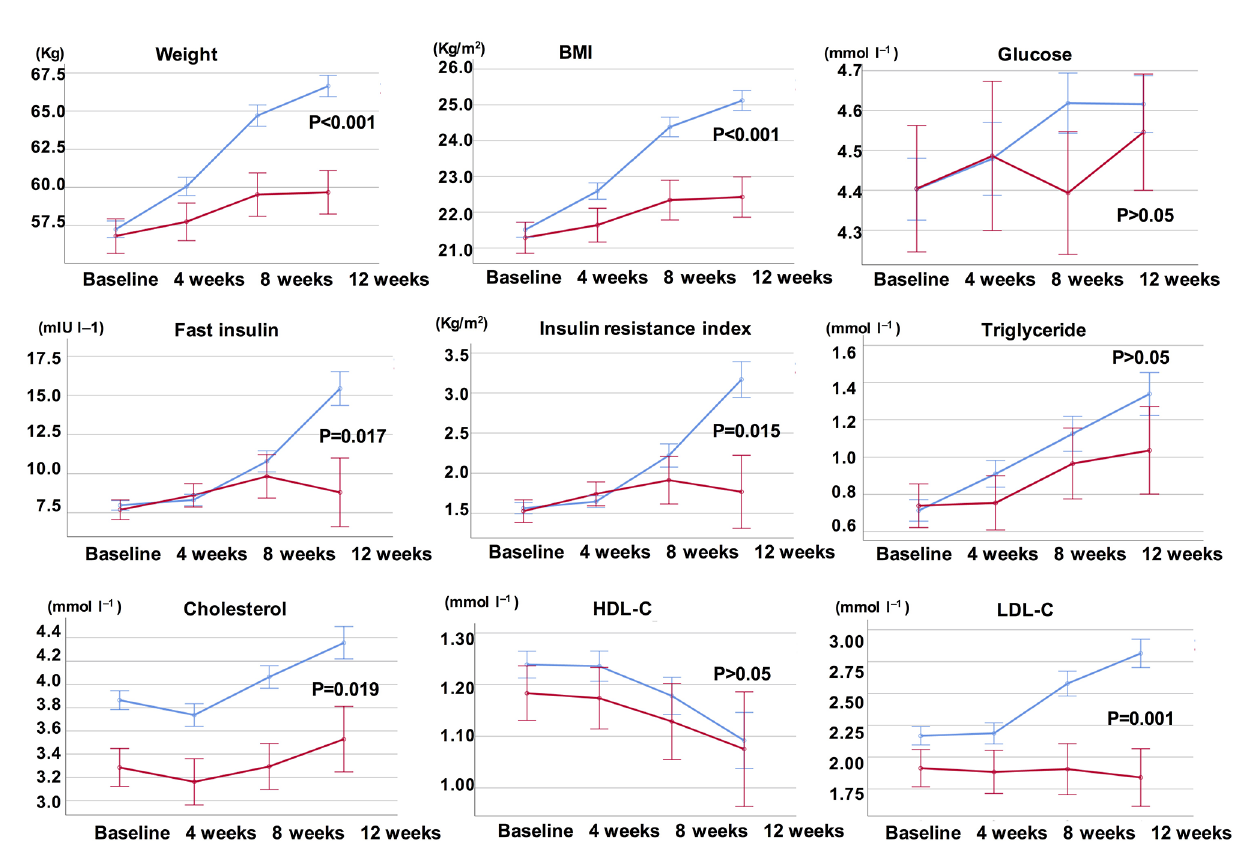
FIGURE 2 | Comparison of body weight, BMI, glucose, and lipid levels between increased and unchanged appetite groups. Blue line indicates patients with increased appetite; red line indicates patients with unchanged